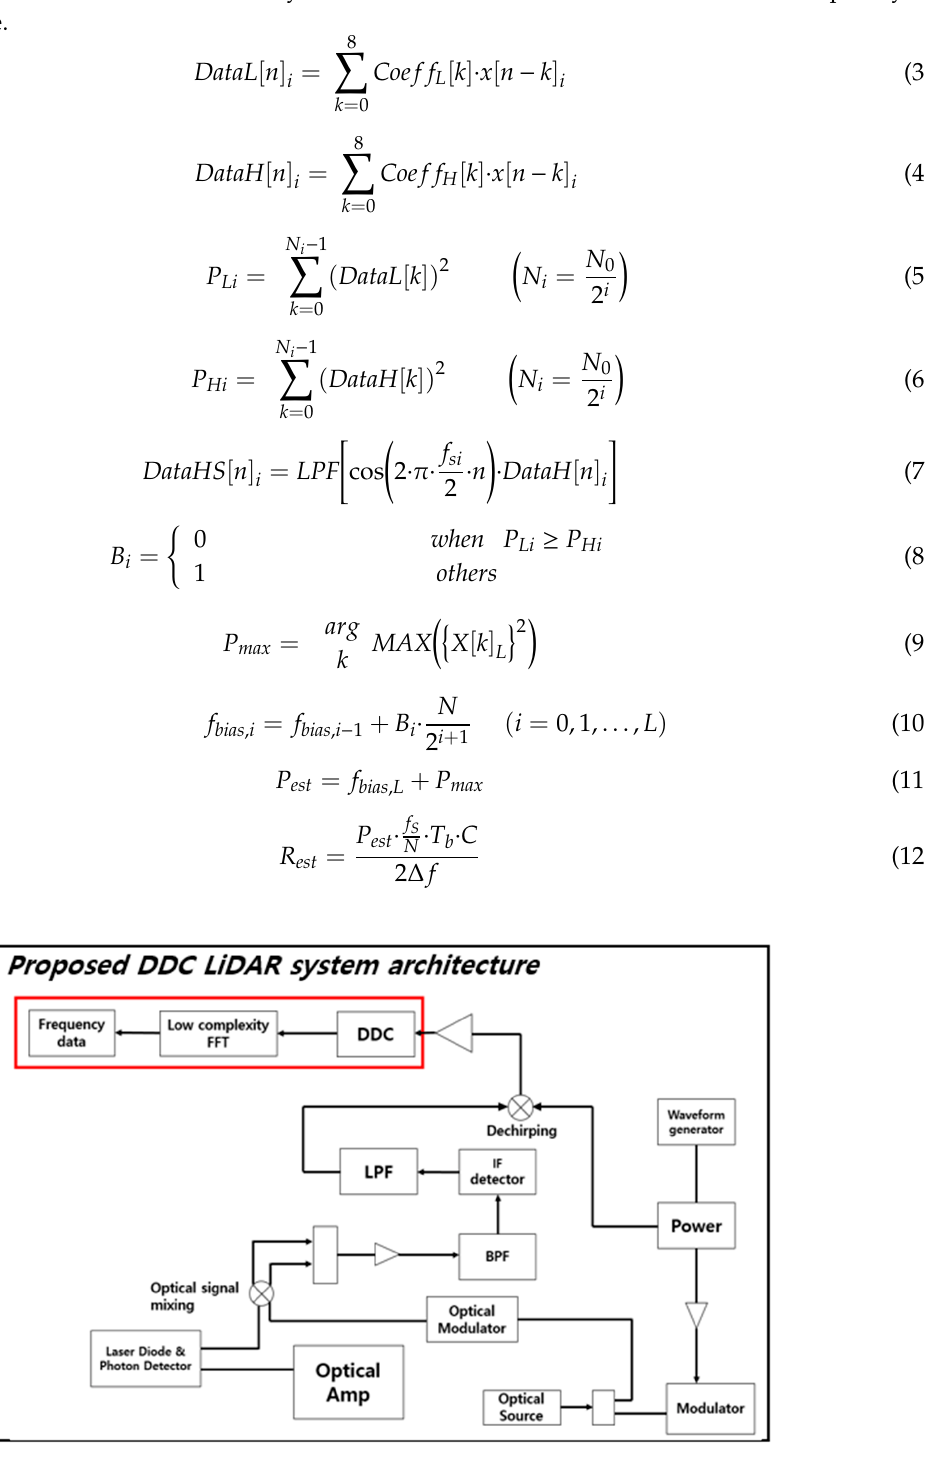
Figure 2. Proposed Coherent Heterodyne Detection FMCW LiDAR Architecture.